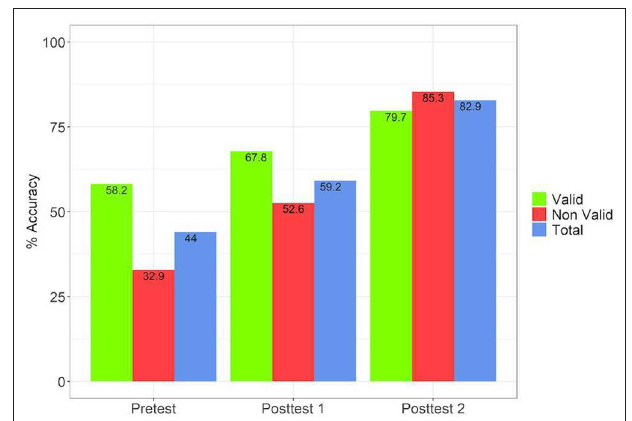
FIGURE 7 | Performance on the 3 tests of Experiment 2.